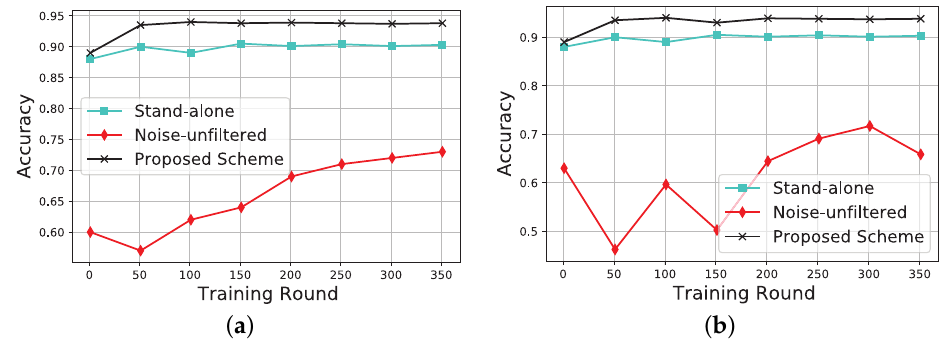
Figure 3. Training convergence against the number of training rounds. ( a ) NDP noise data are 30%. ( b ) NDP noise data are 50%.